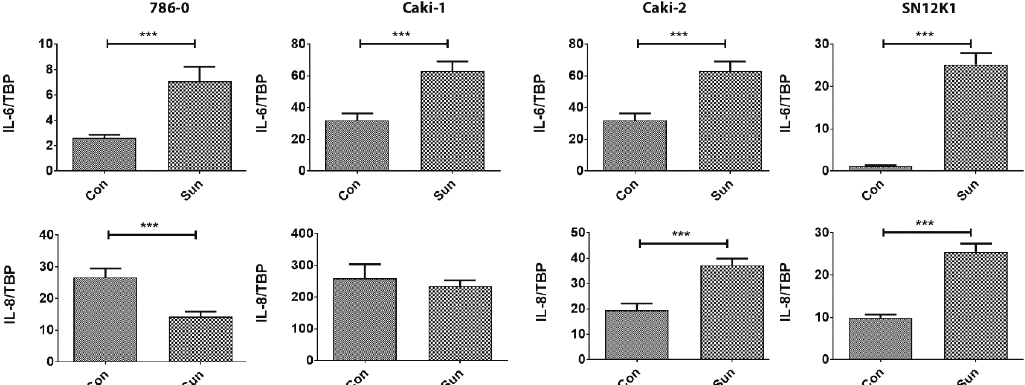
Figure 6. IL-6 is increased in all resistant cells. IL-6 was the common molecule that was increased in all sunitinib-resistant cells. Regarding IL-8, heterogeneity in expression was observed. ***P < 0.001.